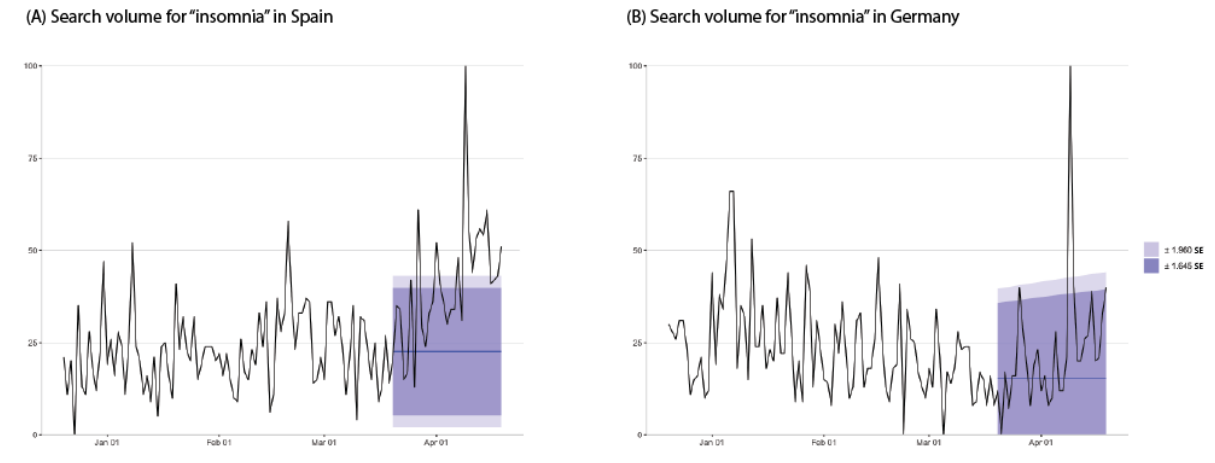
Figure 1. Daily trends for all Google searches for the term “insomnia” alongside expected trends for the days after March 20, 2020, in (A) Spain and (B) Germany.